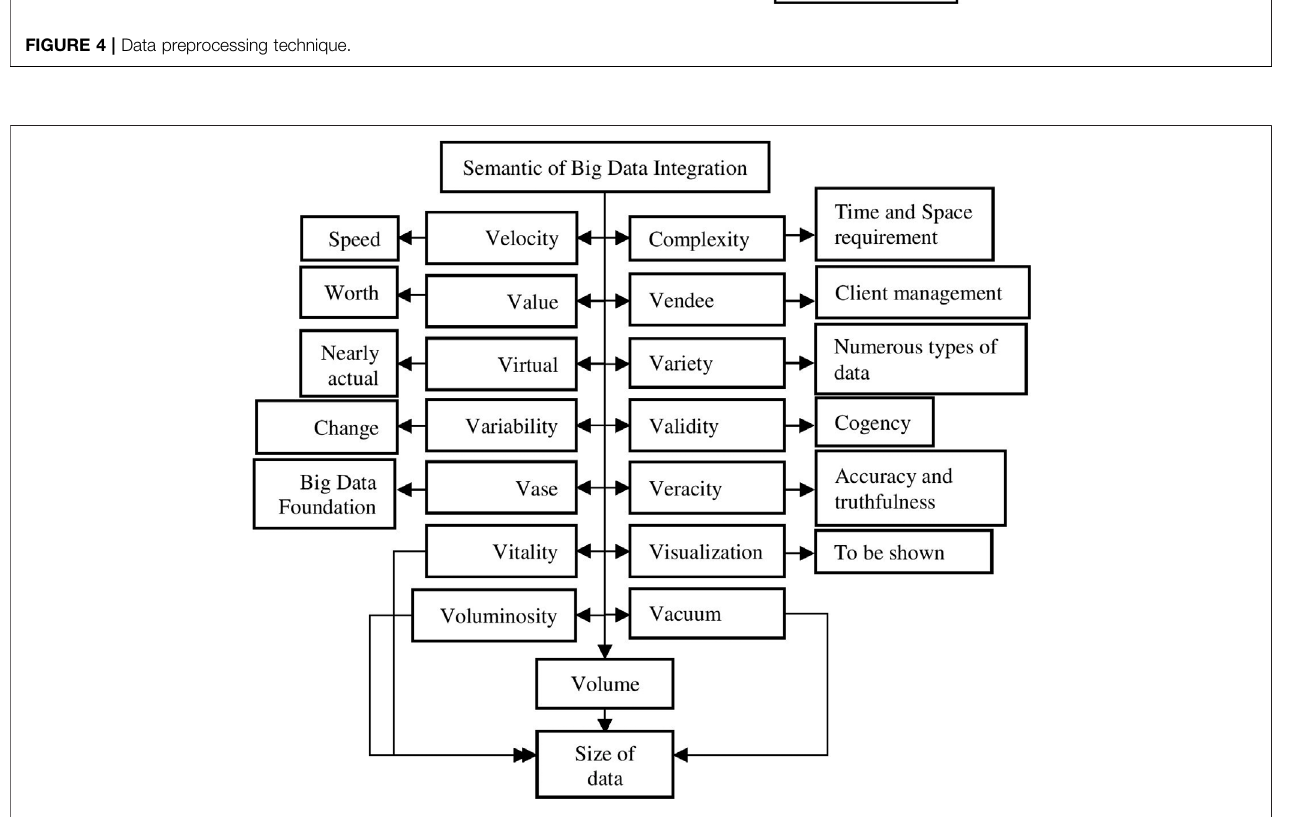
FIGURE 5 | The data integration parameter family and its meaning.